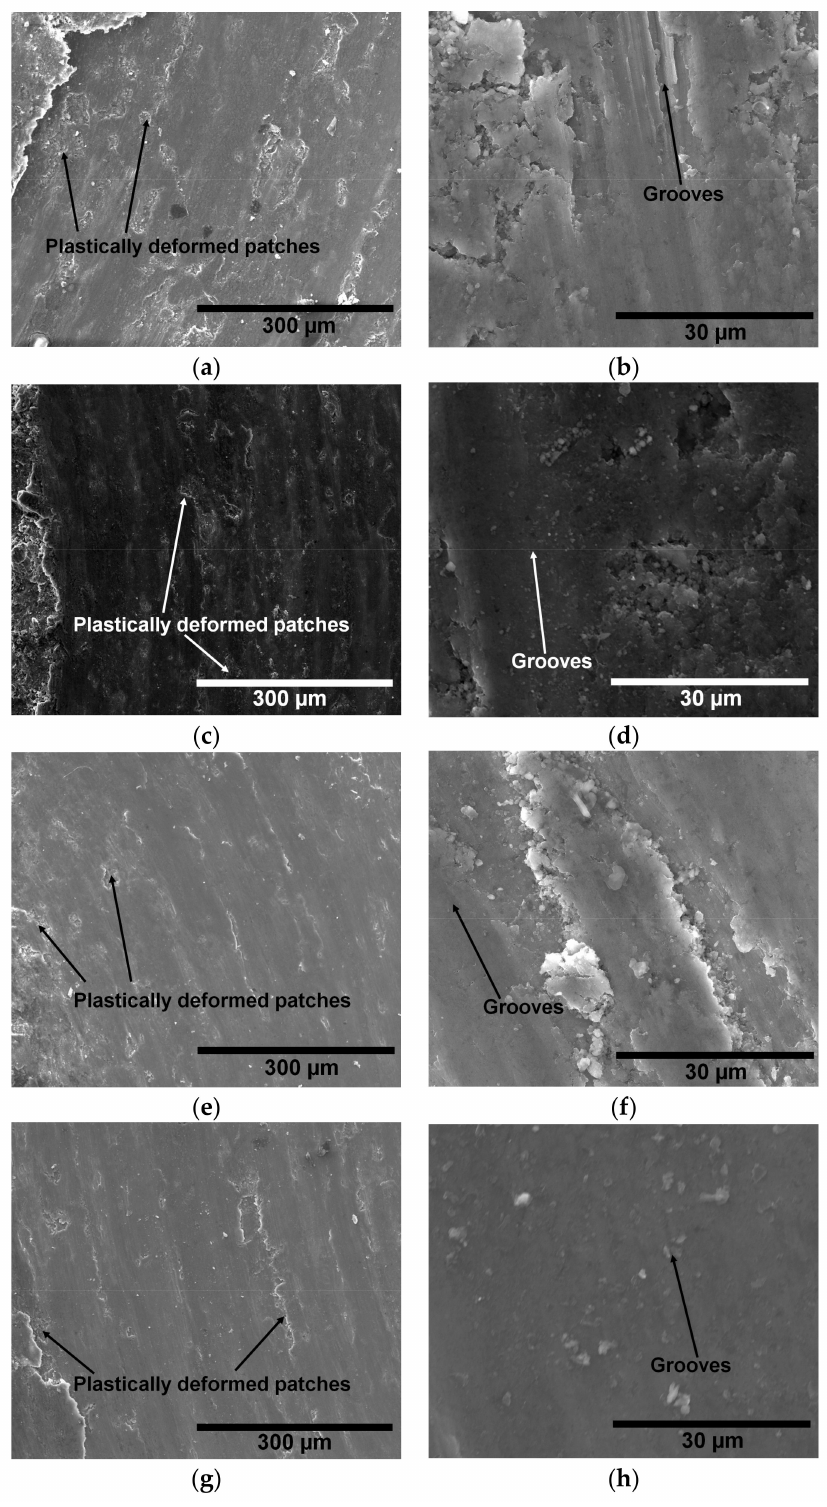
Figure 6. Low and higher magnification microstructures of wear surfaces of laser clad Al-SiC composites: ( a , b ) laser melted (LM); ( c , d ) laser melted and remelted (RM); ( e , f ) laser melted under the influence of simultaneous influence of ultrasonic vibrations (ULM); and ( g , h ) laser melted and then remelted under the influence of simultaneous influence of ultrasonic vibrations